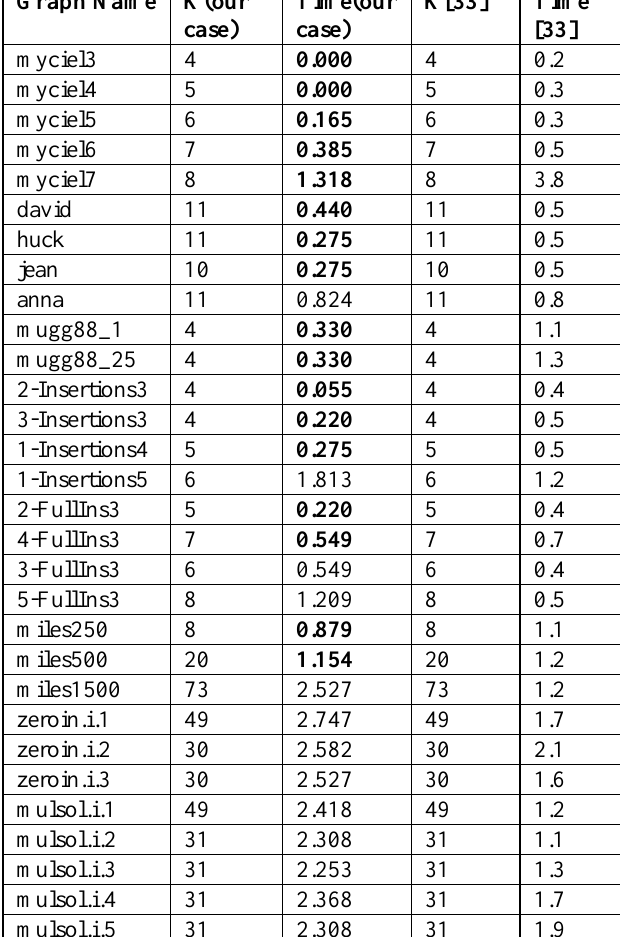
Table 8: Comparison results with our case & MOCA [33]